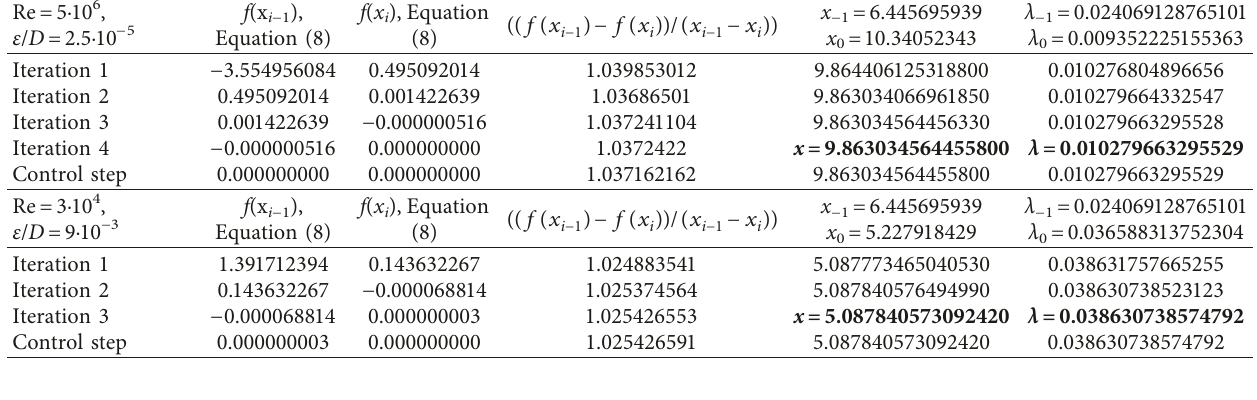
Table 9: Secant procedure. Option 9: two initial starting points x � 6.445695939 0 and x − 1 required: starting point λ − 1 is with fixed value x − 1 (i.e., λ − 1 � 0.024069128765101) as in Section 2.2.1, while starting point λ 0 depends on input parameters: Equation (2), and indirect calculation of λ through the transmission factor x : Equation